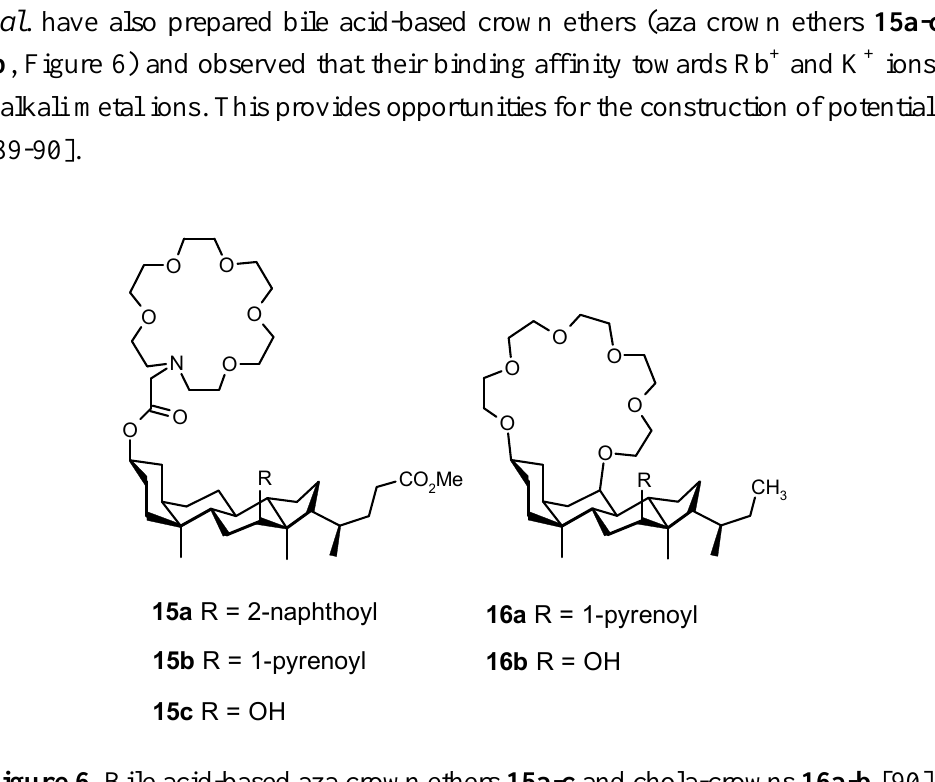
Figure 6. Bile acid-based aza crown ethers 15a-c and chola-crowns 16a-b [90].